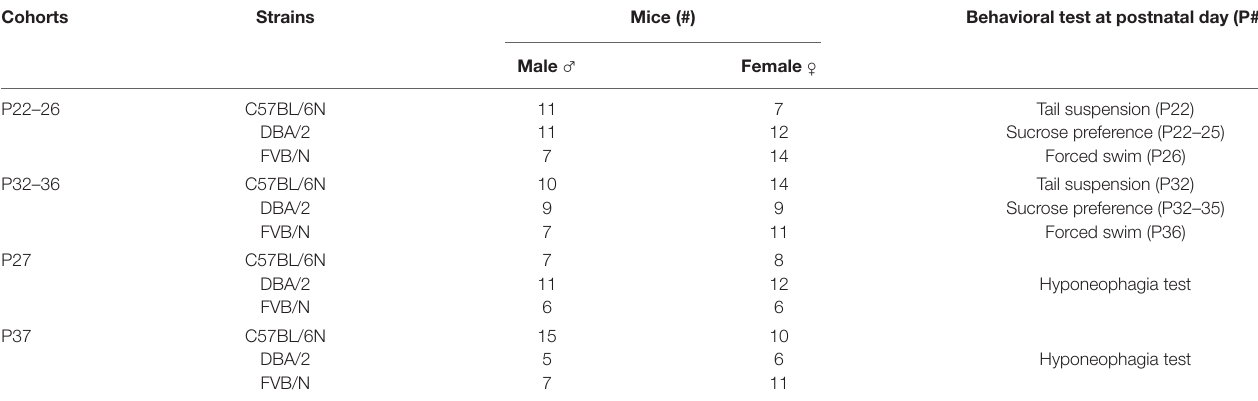
TABLE 1 | Mouse cohorts, number and age of the adolescent mice used in the behavioral test battery. Cohorts Strains Mice